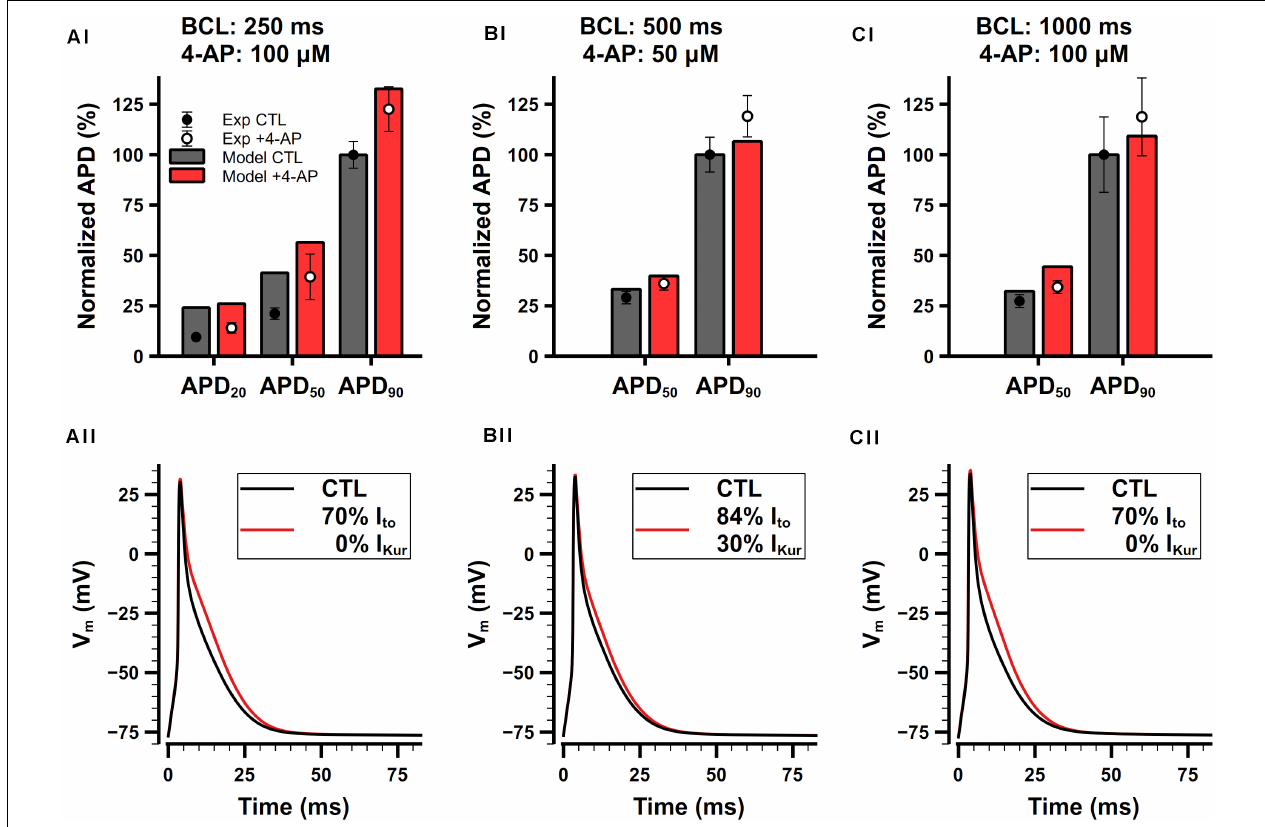
FIGURE 13 | Role of I to and I Kur in the mouse atrial cell model. (Ai,Aii) Comparison of normalized APDs with experimental data (Ai) and simulated APs (Aii) before and after the application of 100- µ M 4-AP. The cell was paced at 4 Hz. Experimental data was extracted from Trépanier-Boulay et al. (2004). (Bi,Bii) Comparison of normalized APDs with experimental data (Bi) and simulated APs (Bii) before and after the application of 50- µ M 4-AP. The cell was paced at 2 Hz. Experimental data was extracted from Nakamura et al. (2010). (Ci,Cii) Comparison of normalized APDs with experimental data (Ci) and simulated APs (Cii) before and after the application of 100- µ M 4-AP. The cell was paced at 1 Hz. Experimental data was extracted from Lomax et al.